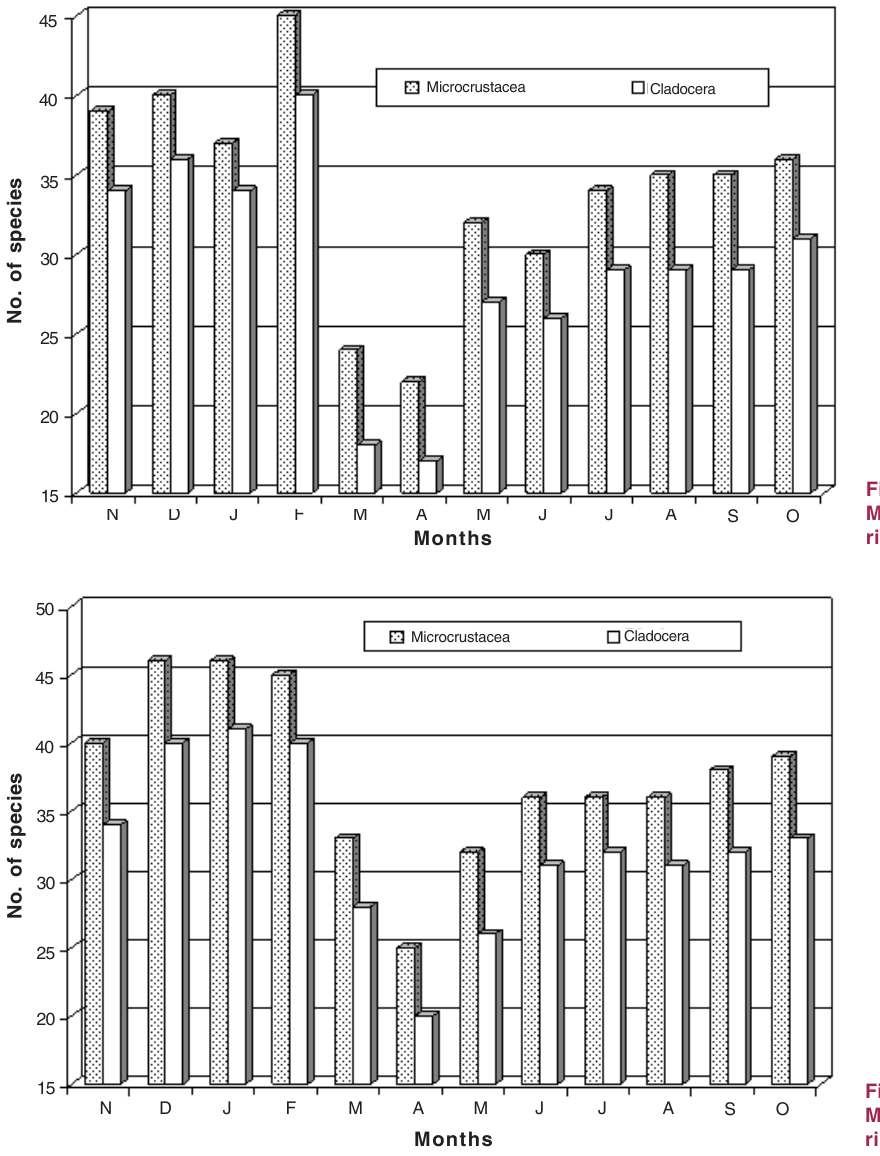
Figure 2. Monthly variations in Microcrustacea and Cladocera